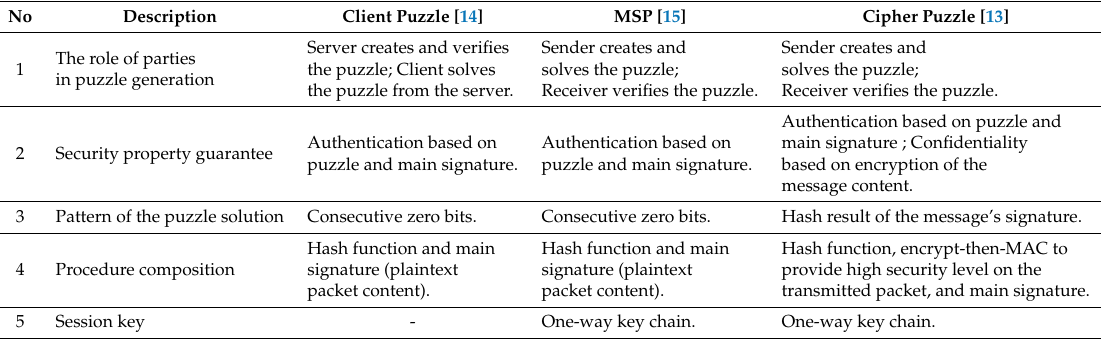
Table 2. Comparison between Client Puzzle, Message Specific Puzzle and Cipher